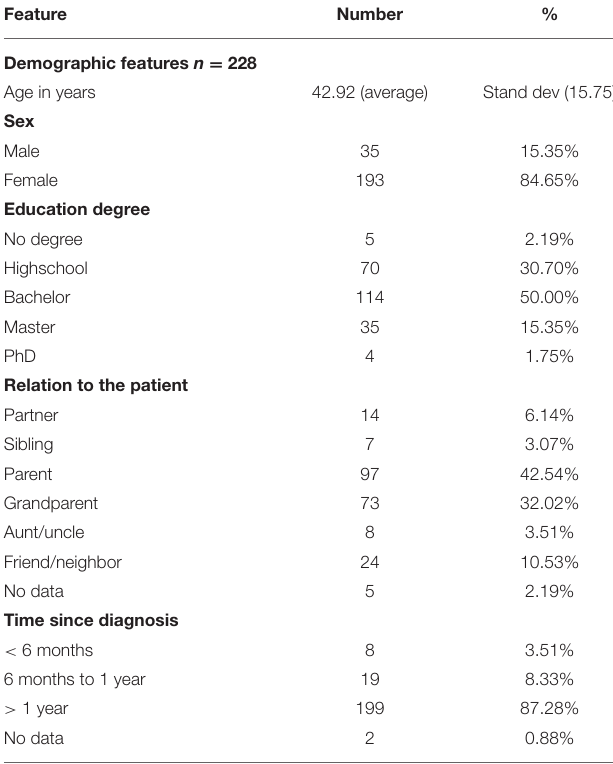
TABLE 1 | Background features of the